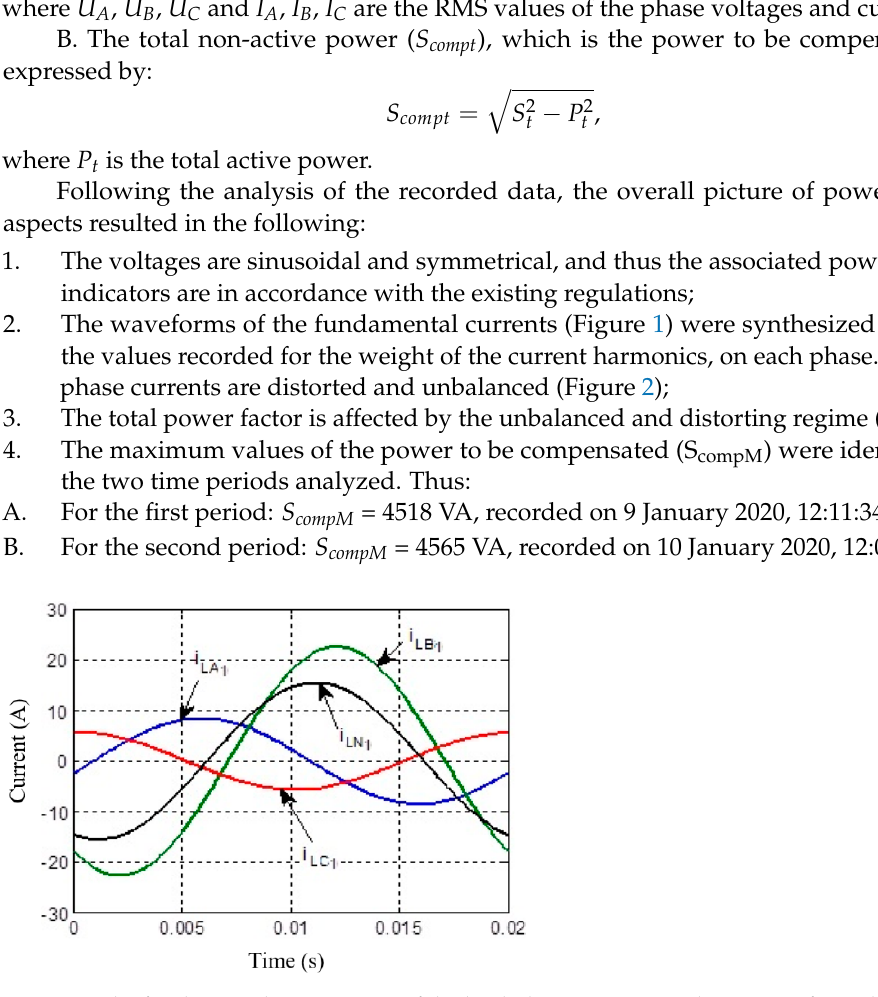
Figure 1. The fundamental components of the load phase currents in the most unfavorable case.